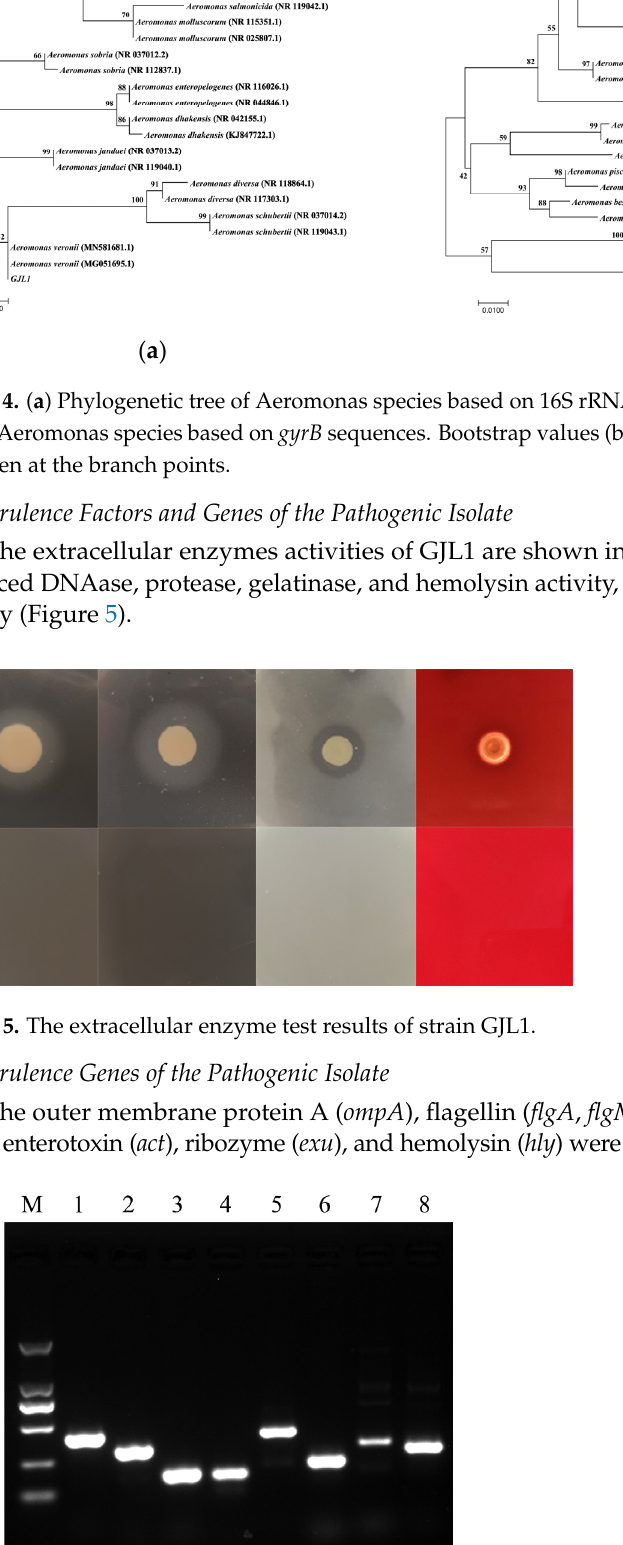
Figure 6. Virulence genes of A. veronii GJL1 by PCR amplification. M, Trans 2K DNA Marker; Lane 1 ompA ; Lane 2, flgA ; Lane 3, flgM ; Lane 4, flgN ; Lane 5, aer ; Lane 6, act ; Lane 7, exu ; Lane 8, hly .